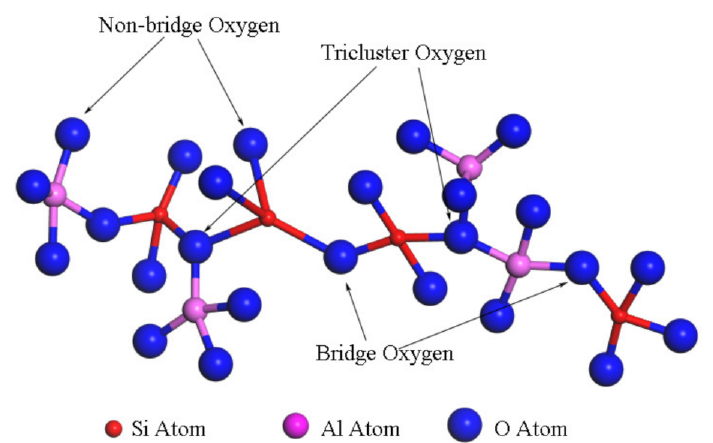
Figure 3. Illustration of different oxygen units.